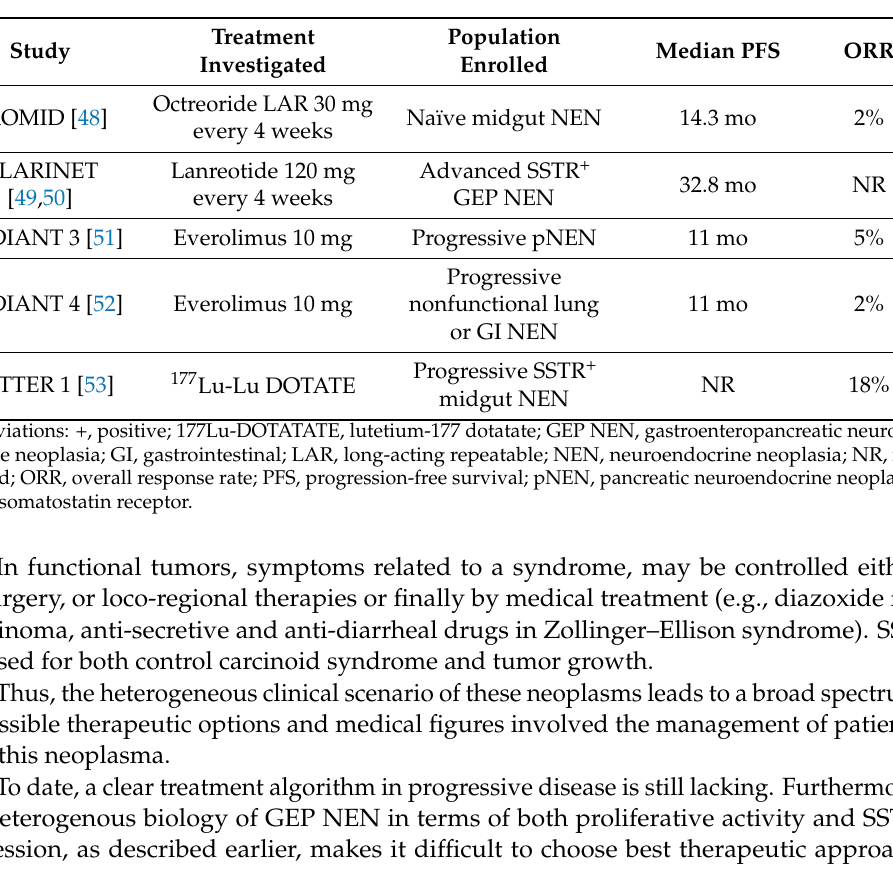
Table 1. Approved medical treatment for advanced G1-G2 GEP